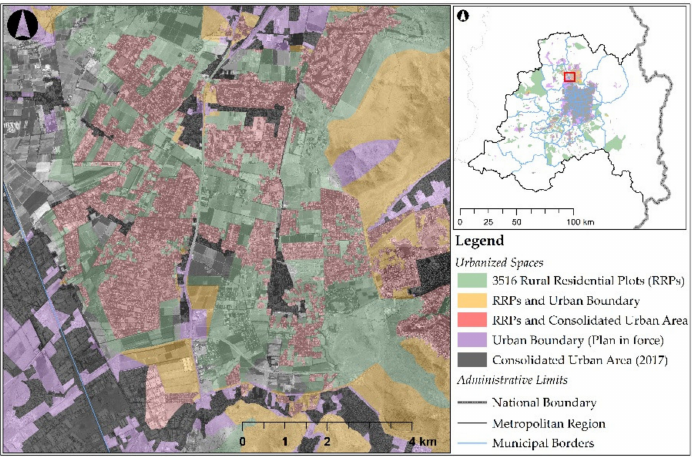
Figure 3. The intersection between RRPs and legal city limits in MR. Source: Own elaboration, based on INE (2017) and MINVU